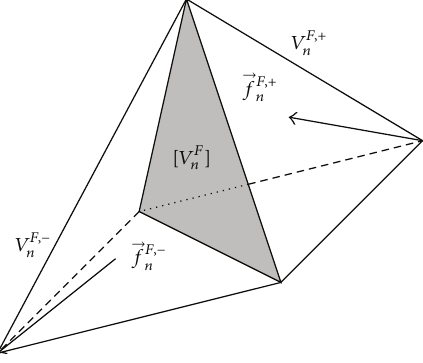
Figure 1: The geometry of the SWG